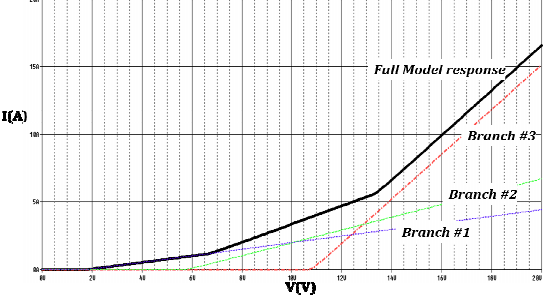
Figure 14: I/V of advanced “diode” model